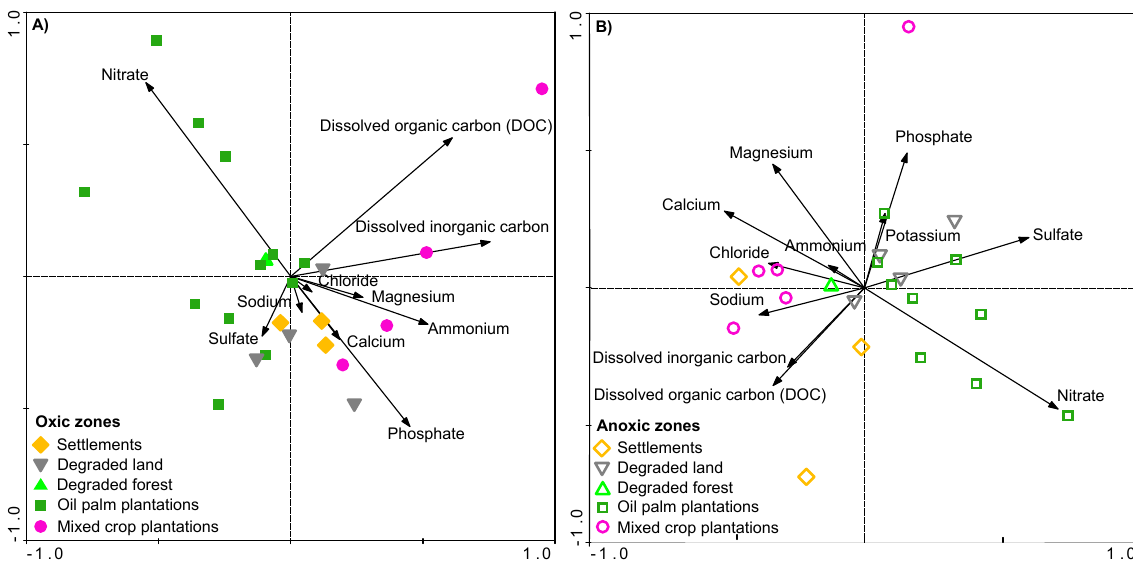
Fig. 4. Canonical correspondence analysis of 16S rDNA gene based T-RFLP data sets and environmental data in different land-use patterns from oxic (a) and anoxic (b) zones. Geochemical data, represented with arrows, are nitrates, dissolved organic carbon (DOC), dissolved inorganic carbon, chloride, magnesium, ammonium, sodium, calcium, sulfate and phosphate. Test of significance ( p value) of all canonical axes is 0.05 and 0.009 in oxic (a) and anoxic (b) zones, respectively.